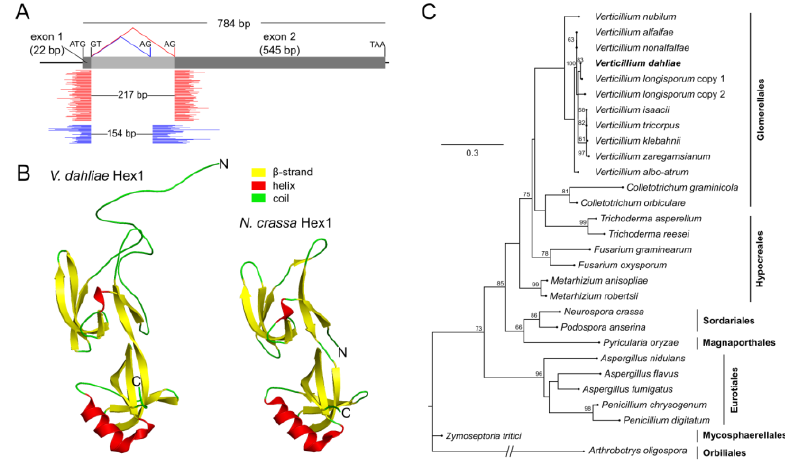
Figure 1. Gene and protein structure of the Hex1 homolog of Verticillium dahliae , and phylogenetic analysis. ( A ) Gene structure of locus VDAG_01749. Mapping of RNA-seq reads on the genomic sequence supports the definition of an intron that can be spliced in two alternative ways (red and blue reads, respectively) to produce two highly similar isoforms of the protein. ( B ) Prediction by homology Neurospora crassa homolog (PDB 1KHI). ( C ) Maximum likelihood phylogenetic tree of Hex1 homologs